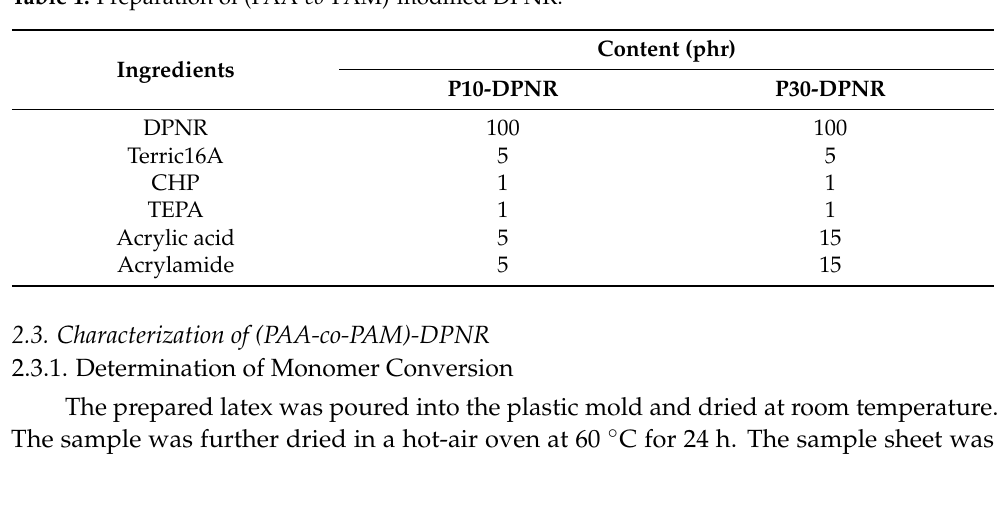
Table 1. Preparation of (PAA- co -PAM)-modified